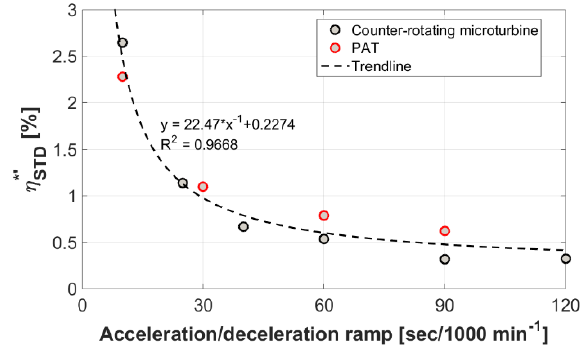
Figure 7. Influence of the acceleration/deceleration ramp of the runner(s) speed on the efficiency fluctuation during one forth and back cycle at fixed testing inflow conditions: ( a ) counter-rotating microturbine—constant test rig pumps’ speed of N p1,2,3 = 1500 min −1 ; ( b ) PAT—constant test rig pumps’ speed of N p1,2,3 = 2000 min −1 .